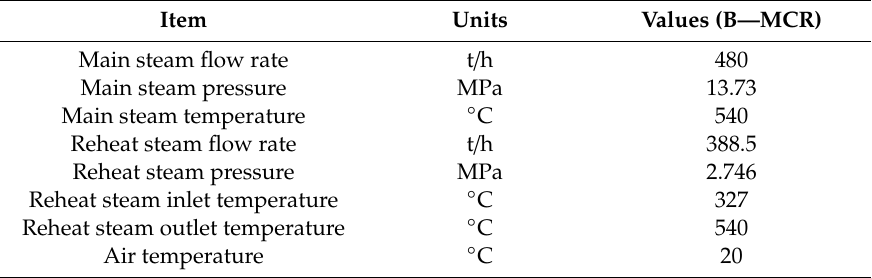
Table 2. Main design parameters (Reprint with permission [8]; 2016, J. China Coal